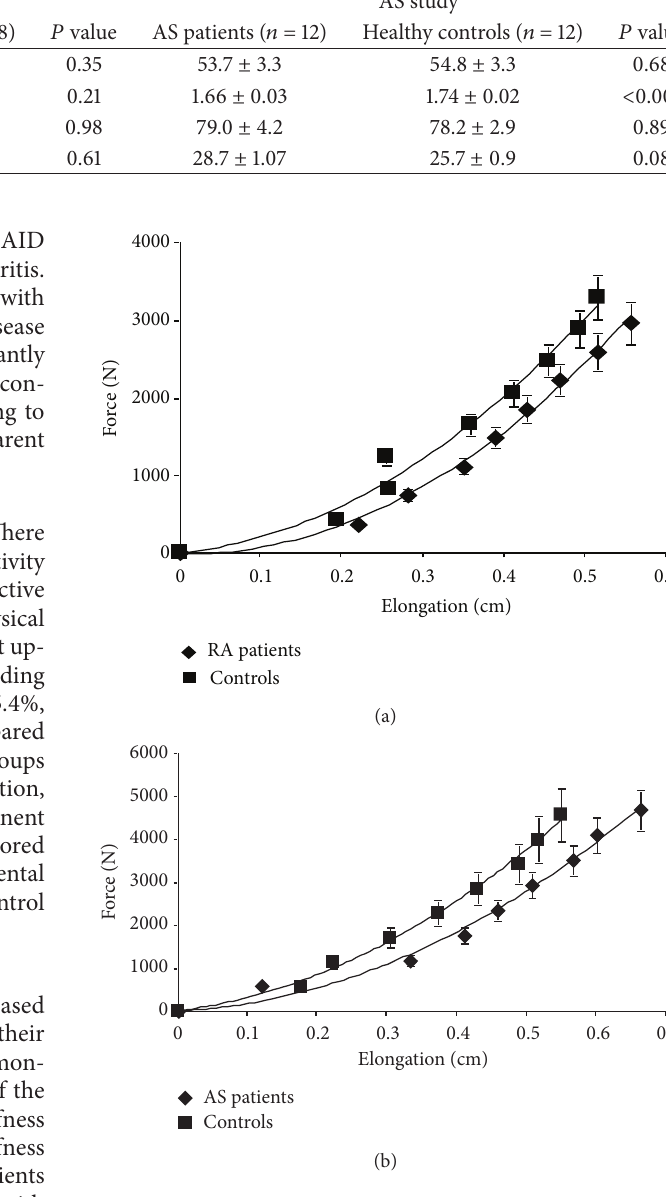
Figure 2: PT force-elongation relationship in RA patients ( 𝑛 = 18 ) (a) and AS patients ( 𝑛 = 12 ) (b) and their respective matched con- trols. Results are presented as means ±